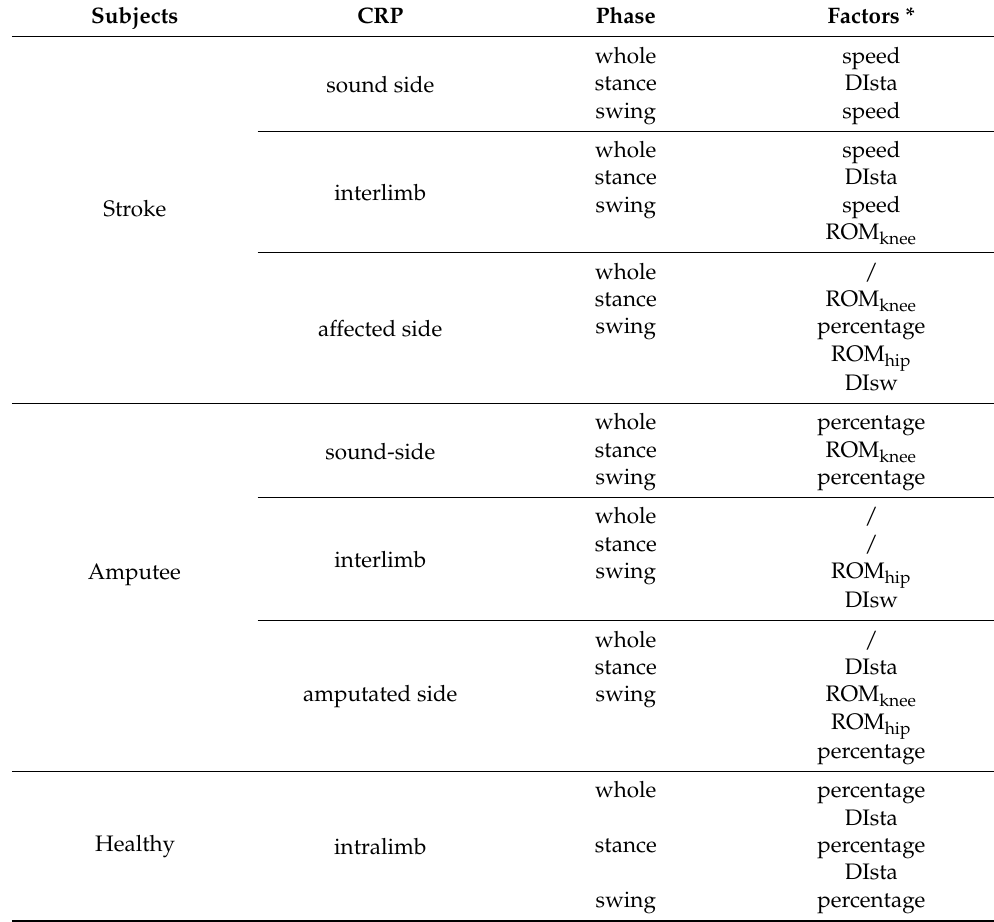
Table 3. Stepwise regression results.